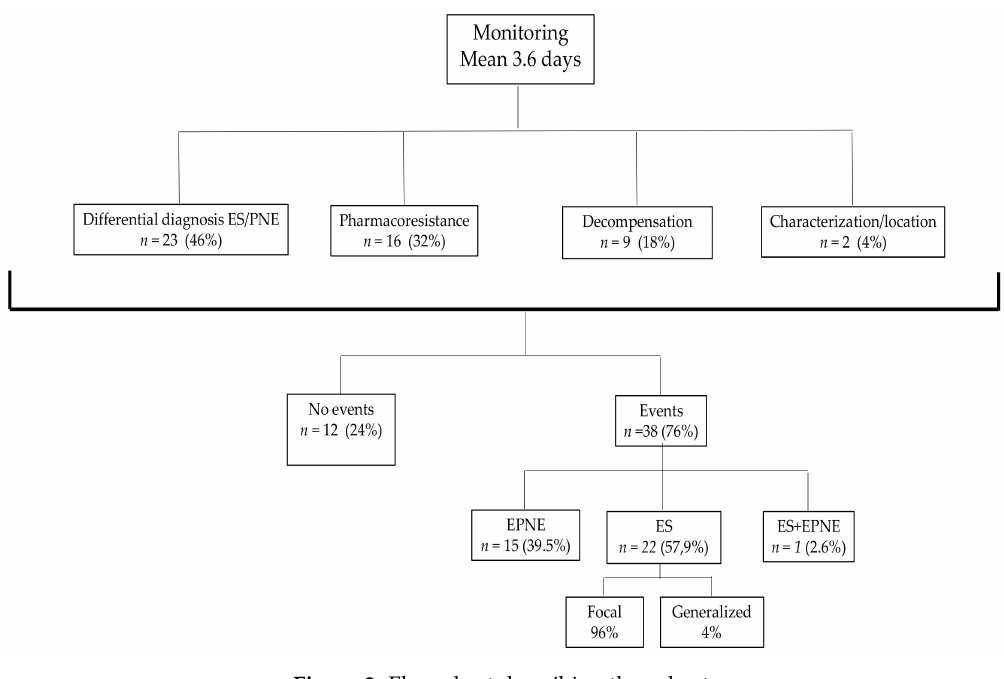
Figure 2. Flow chart describing the cohort.